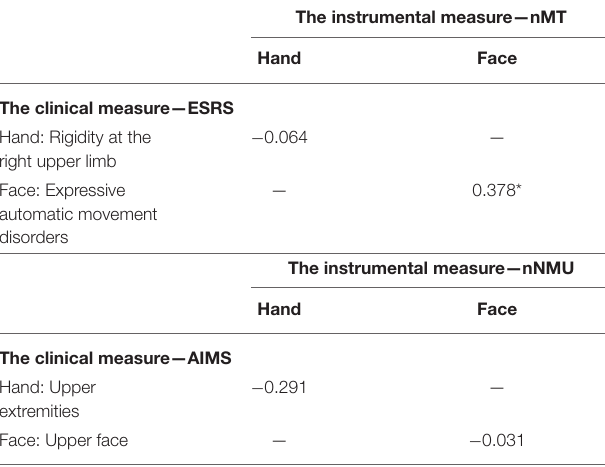
TABLE 4 | Spearman correlation ρ between nMT and the ESRS items and between nNMU and the AIMS items ( N = 36). The instrumental